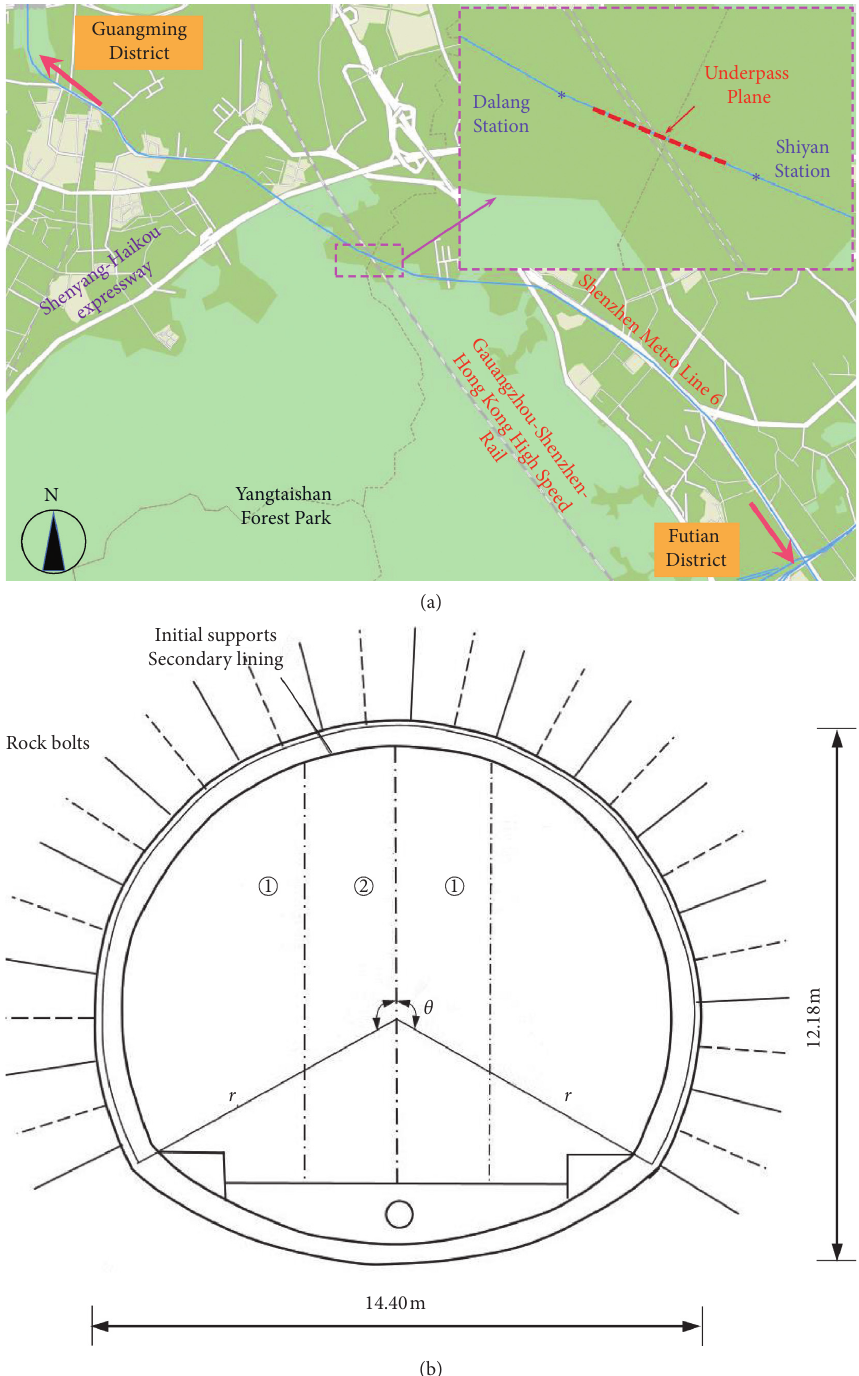
Figure 1: Direction of Shenzhen Metro Line 6 and section of the existing tunnel. (a) Shenzhen Metro Line 6 and the tunnel underpass section. (b) Cross section of the existing tunnel. Notes: ① center line of the railway; ② center line of the tunnel; r � 6.65 m; θ � 108.67 °